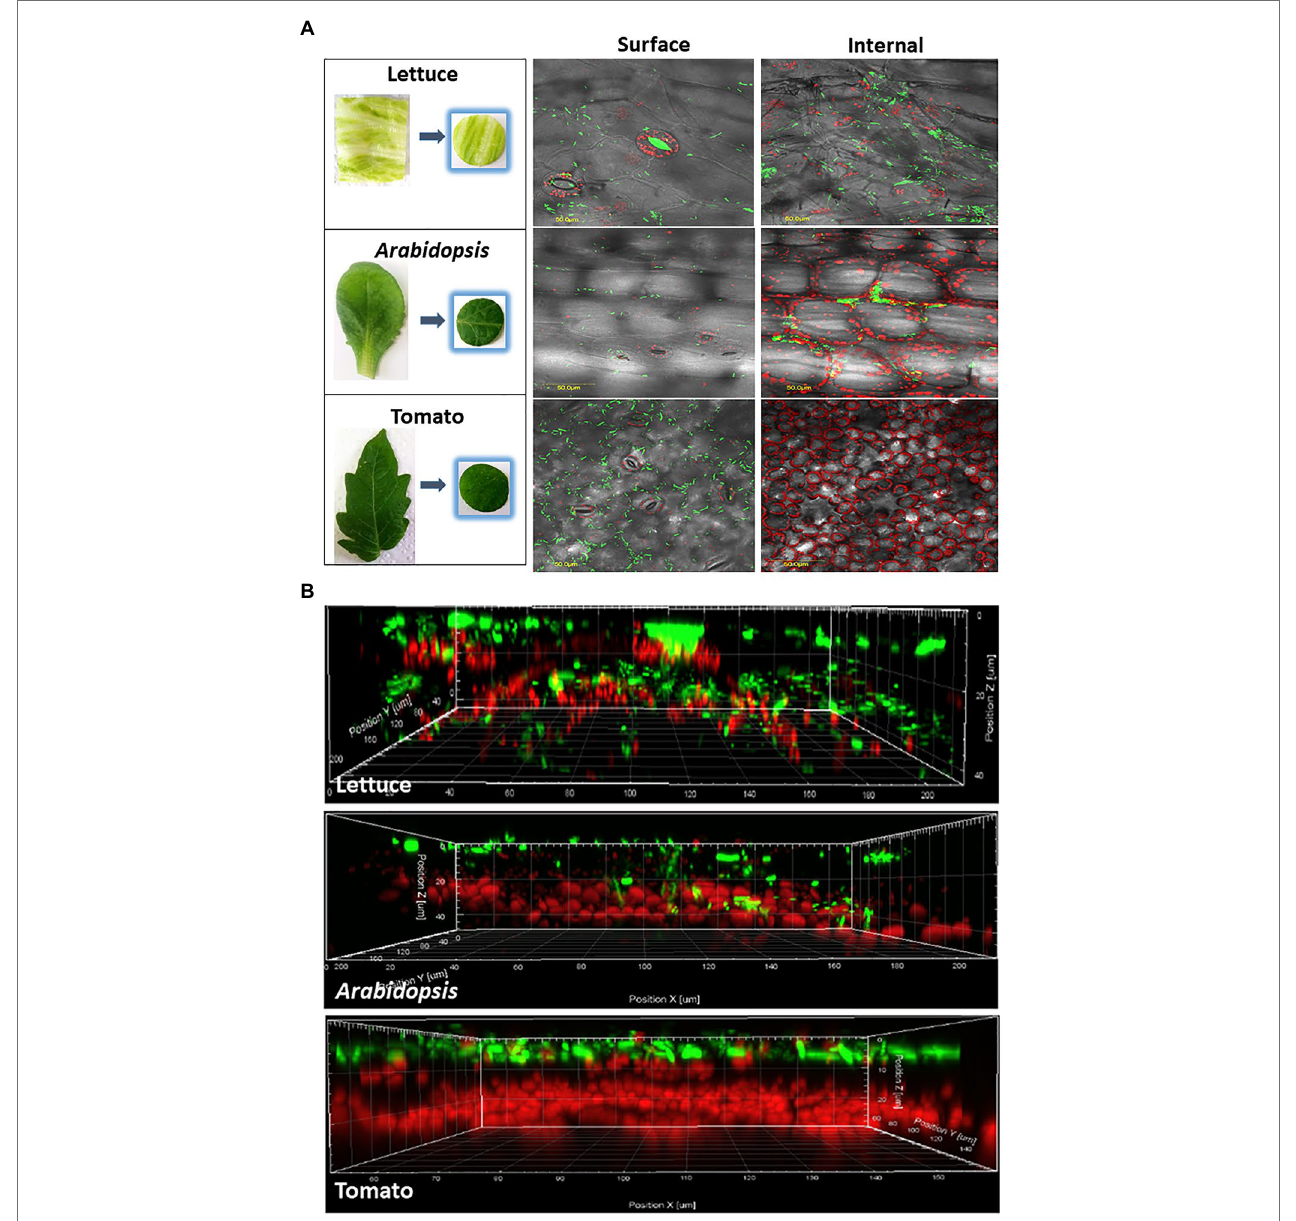
FIGURE 2 | Confocal microscopy visualization illustrating epiphytic and endophytic localization of GFP-labeled Salmonella cells in representative leaves of iceberg lettuce, Arabidopsis , and tomato. Panel A shows images taken from the surface of the leaves, and a stack of fluorescent images along a z -section taken every 1.2 μ m to a depth of 100 μ m below the surface. All images were overlaid with differential interference contrast (DIC) images taken from the same location in each leaf. Bar denotes 50 μ m. Panel B shows a z-section model of the same leaves, demonstrating the location of bacteria (green) on and within the leaf tissues. Red fluorescence indicated autofluorescence of the